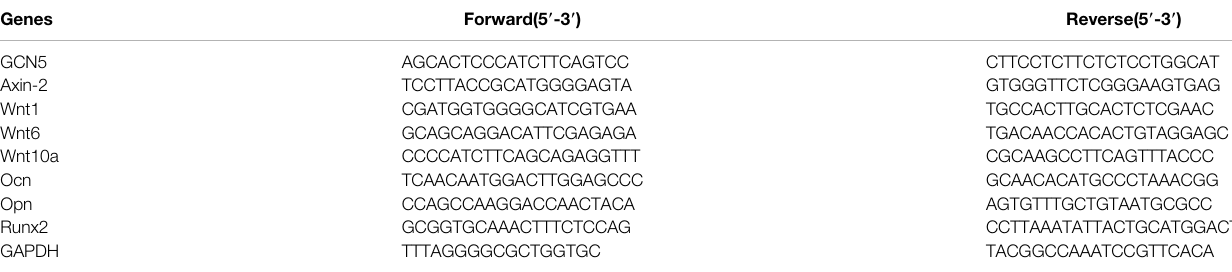
TABLE 1 | Sense and anti-sense primers for real-time PCR.